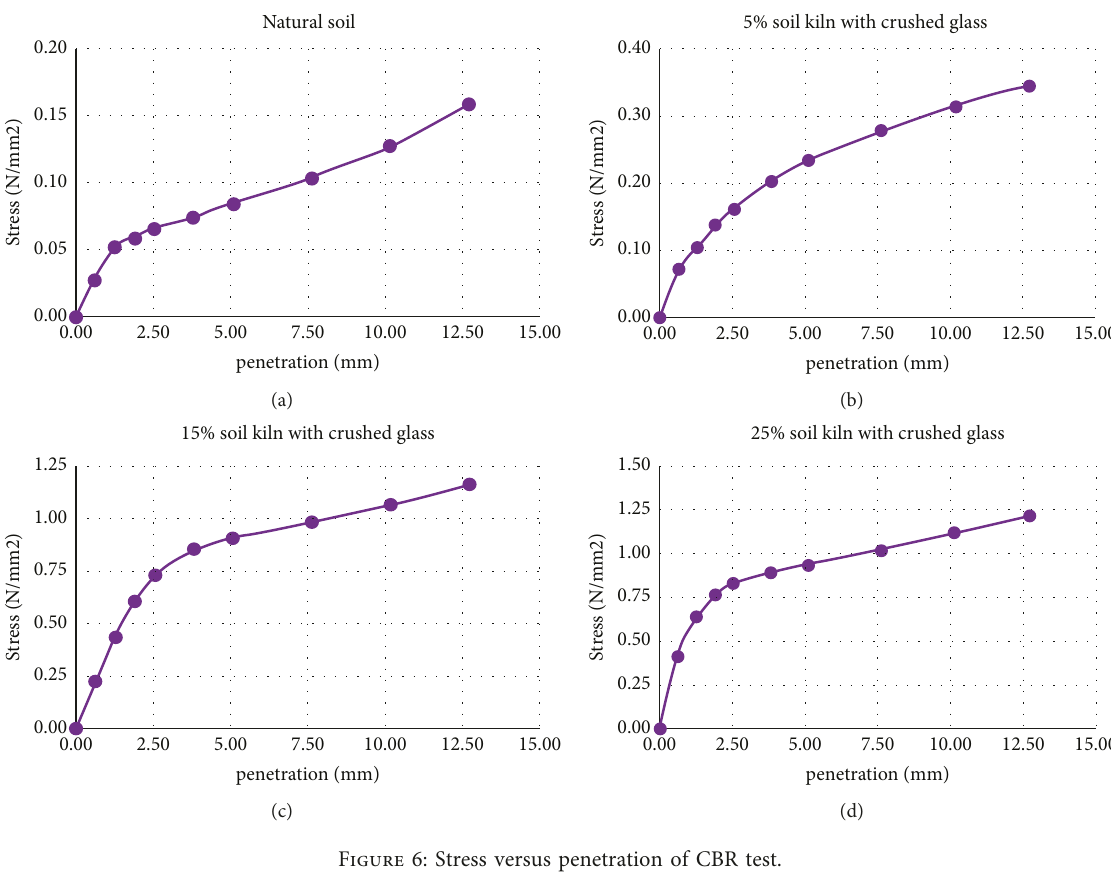
Figure 6: Stress versus penetration of CBR